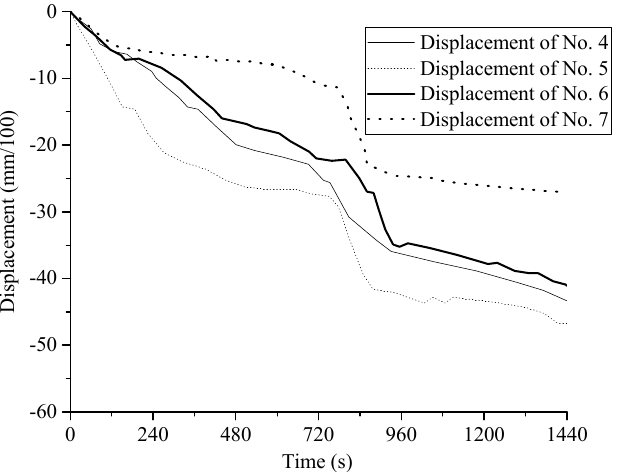
Figure 4. Relation between ground displacement and time of first-up and then-down crossing.